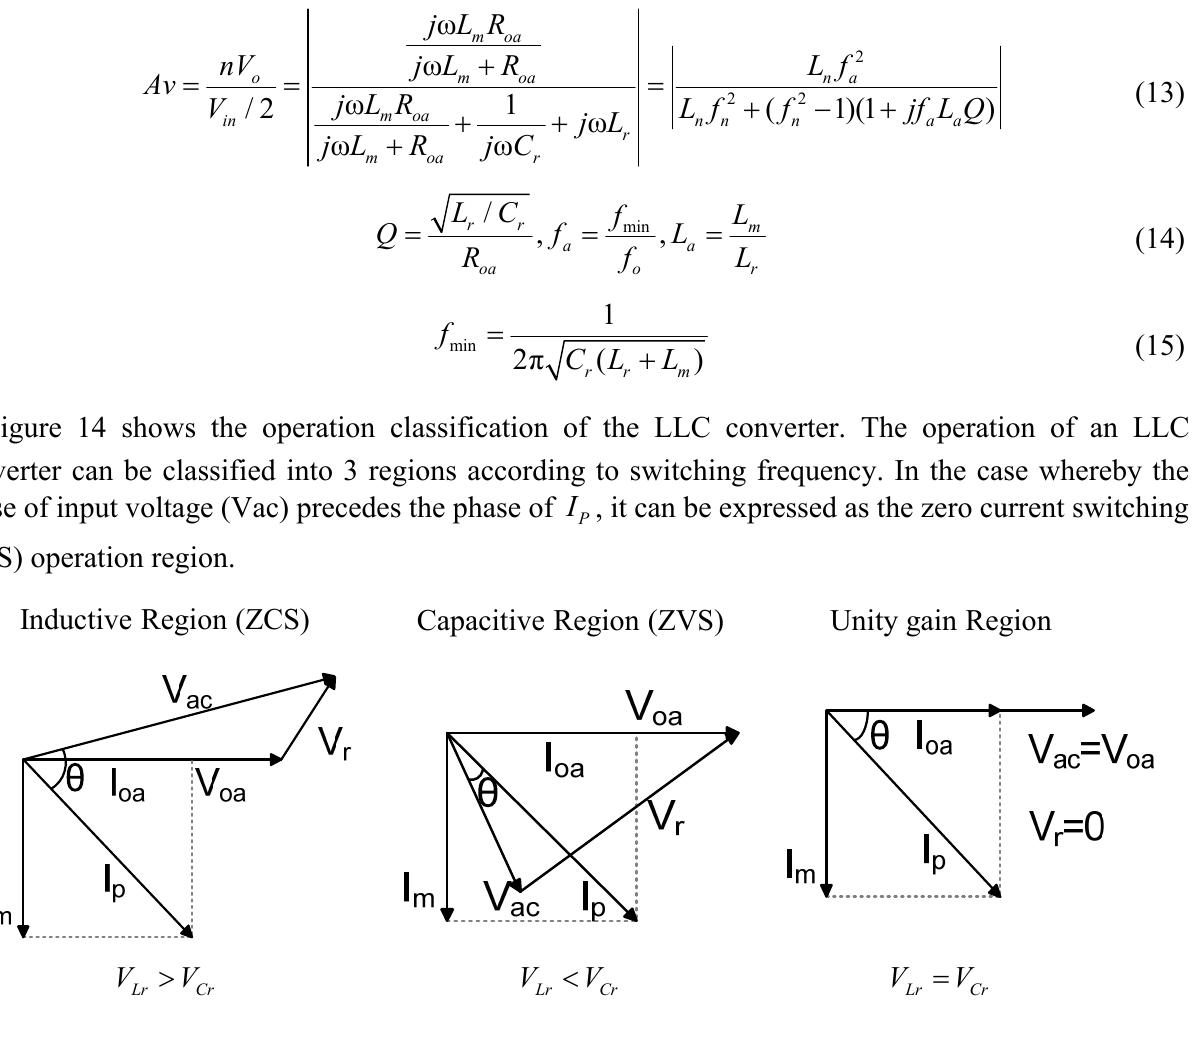
Figure 14. Operating region of LLC resonant